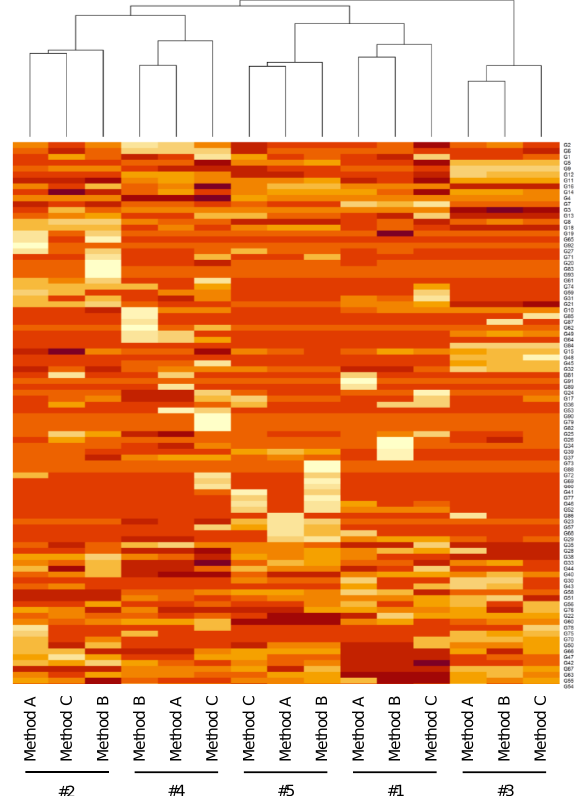
Figure 6. Research I : Heatmap of the gut microbiota composition at the genus level in five adult volunteers. Heatmap of log-transformed values of the relative abundance at the genus level in each method of Research I , using Ward’s method for clustering.